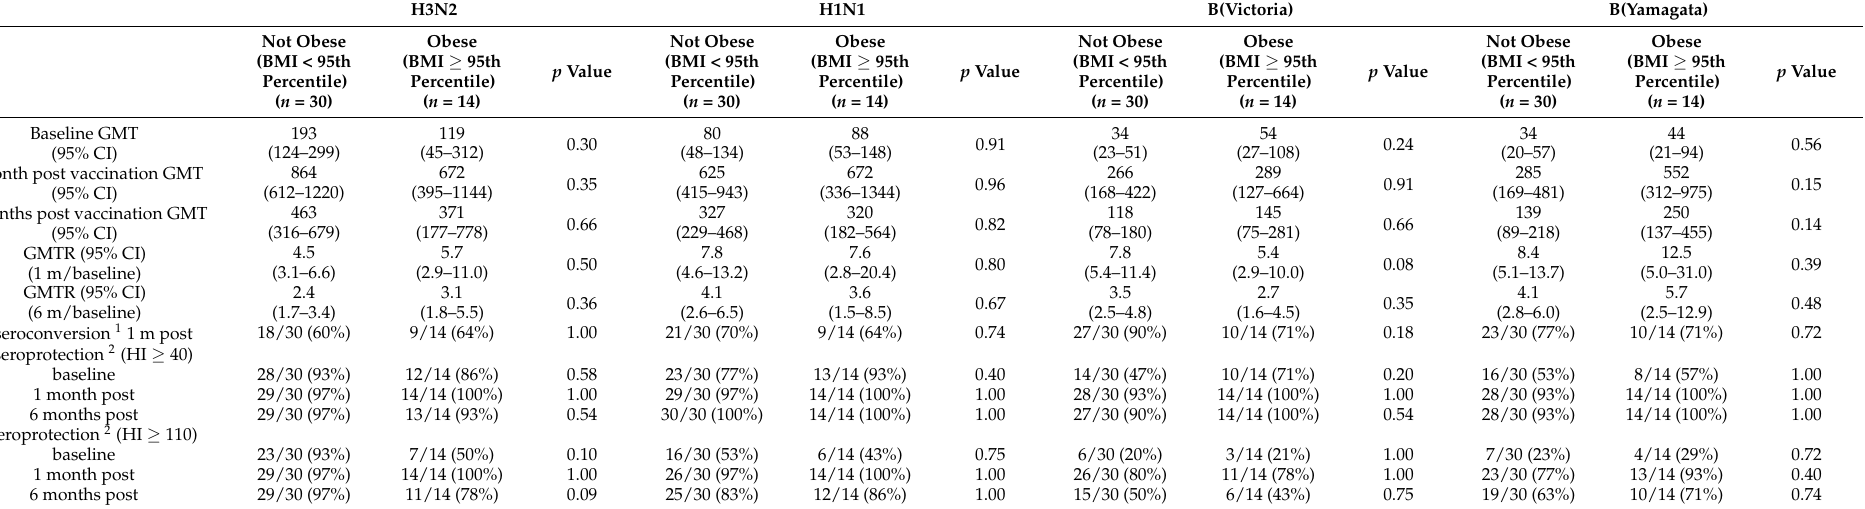
Table 2. Influenza vaccine immunogenicity by influenza strain and obesity